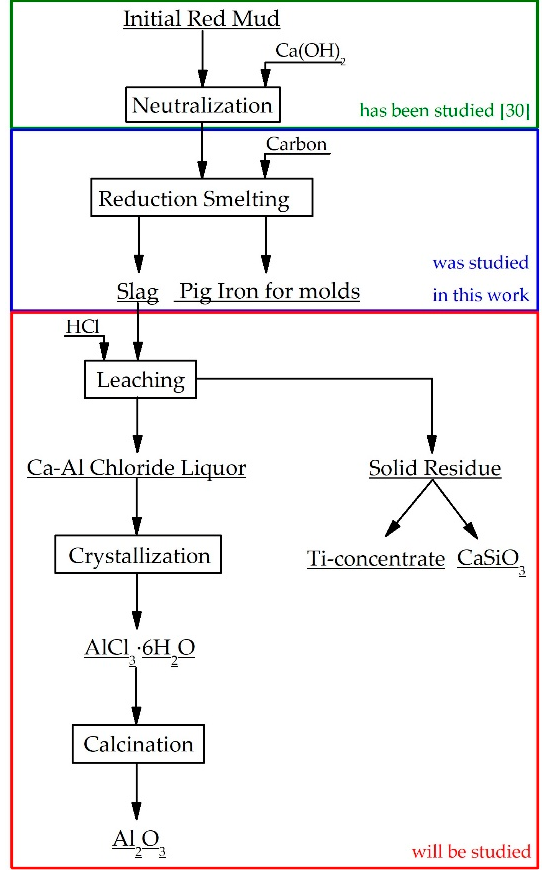
Figure 1. A flowsheet of the recycling treatment of red mud.